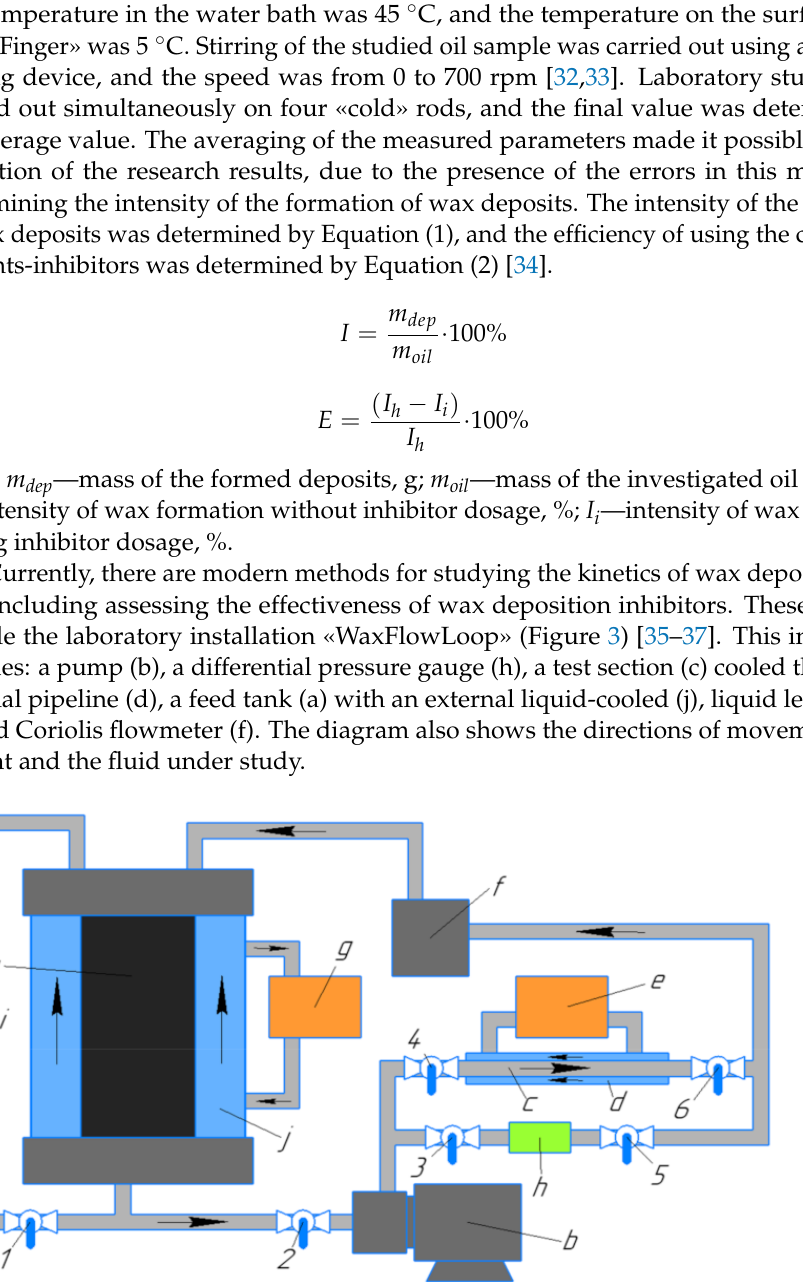
Figure 3. Hydraulic diagram of the laboratory installation